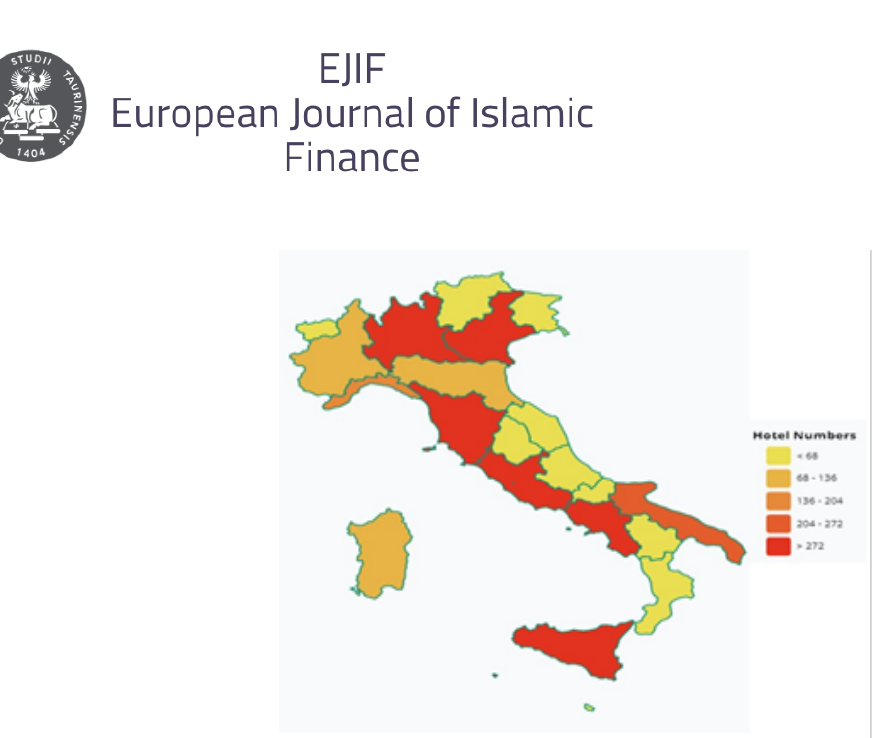
Figure 1. Regional distribution map of halal hotels in Italy